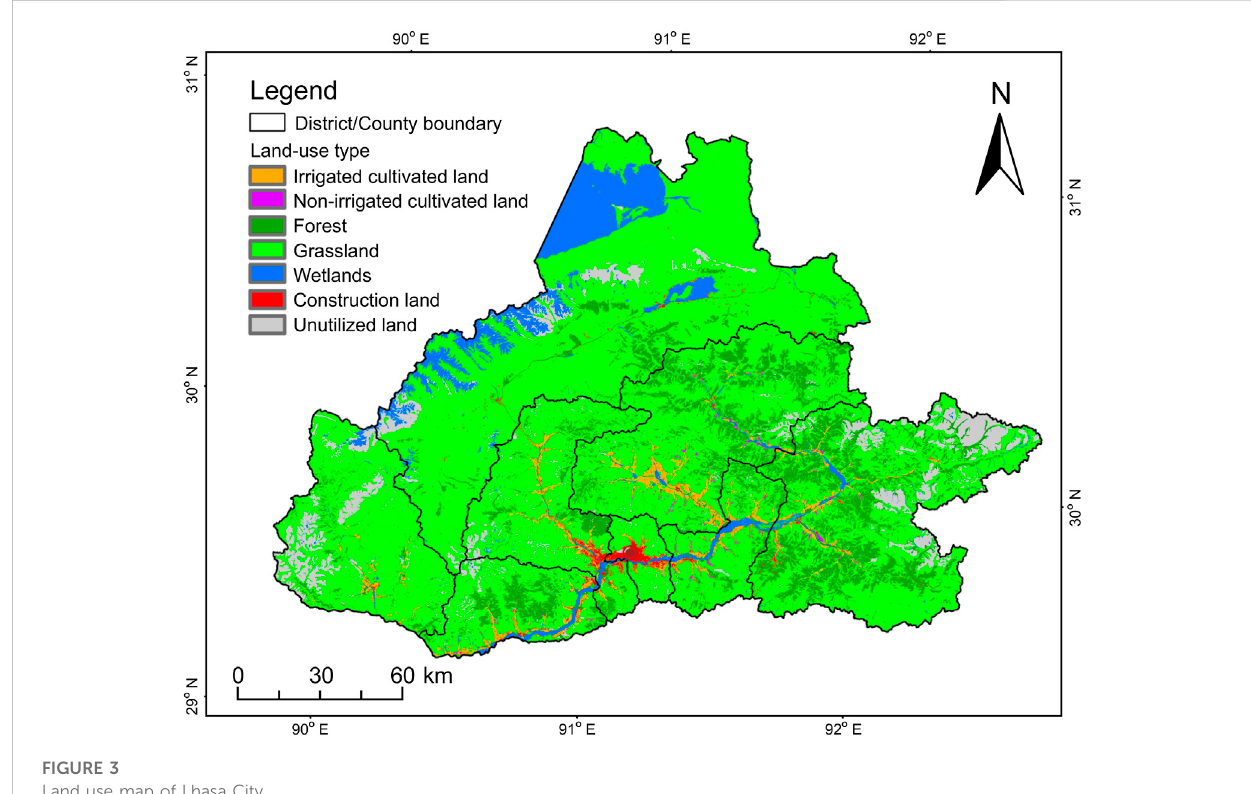
FIGURE 3 Land use map of Lhasa